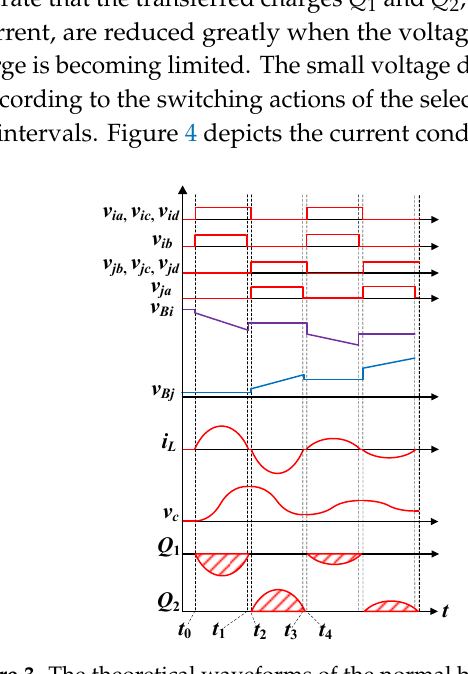
Figure 3. The theoretical waveforms of the normal balance mode.